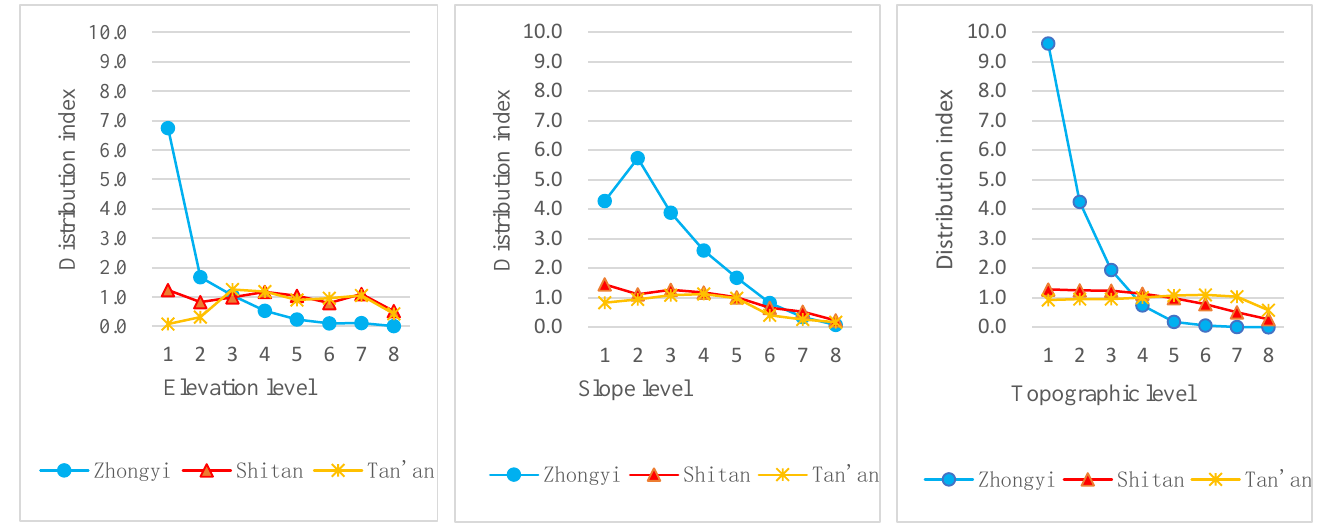
Figure 2. Homestead distribution index at different gradient levels.